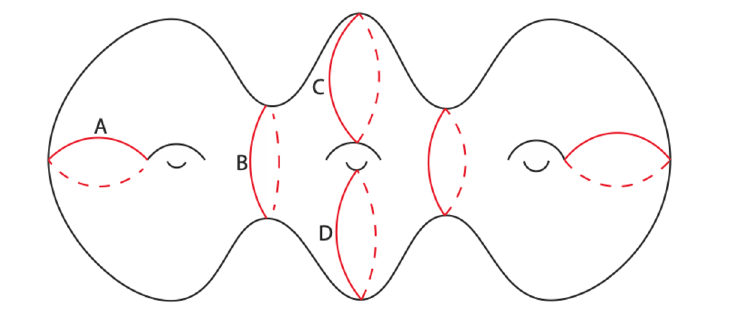
Figure 3 . A surface M of genus g = 3 , with 3 g − 3 = 6 independent circles marked. Surgery on A produces a surface M 1 of genus g 1 = g − 1 = 2 . In passing to M 1 , A disappears, B becomes nullhomotopic, and C and D become homotopic to each other, leaving three independent circles on M 1 . Surgery on B leaves a surface M 0 original 6 independent circles on M , B disappears in the surgery, A remains on M 0 become homotopic. We remain with 3 g 00